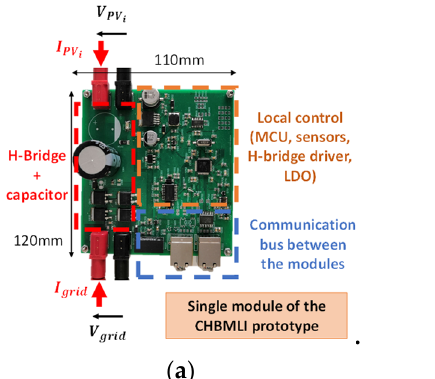
= 3 A , 𝑁 = 8 , 𝑉 (cid:3034)(cid:3045)(cid:3036)(cid:3031)(cid:3045)(cid:3040)(cid:3046) = 180 V : Current (cid:3293)(cid:3288)(cid:3294) (green) (cid:3284)